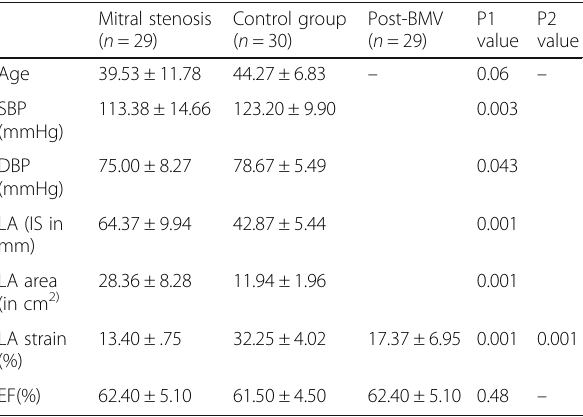
Table 2 Transthoracic echocardiographic and 2D STE findings before and after balloon mitral